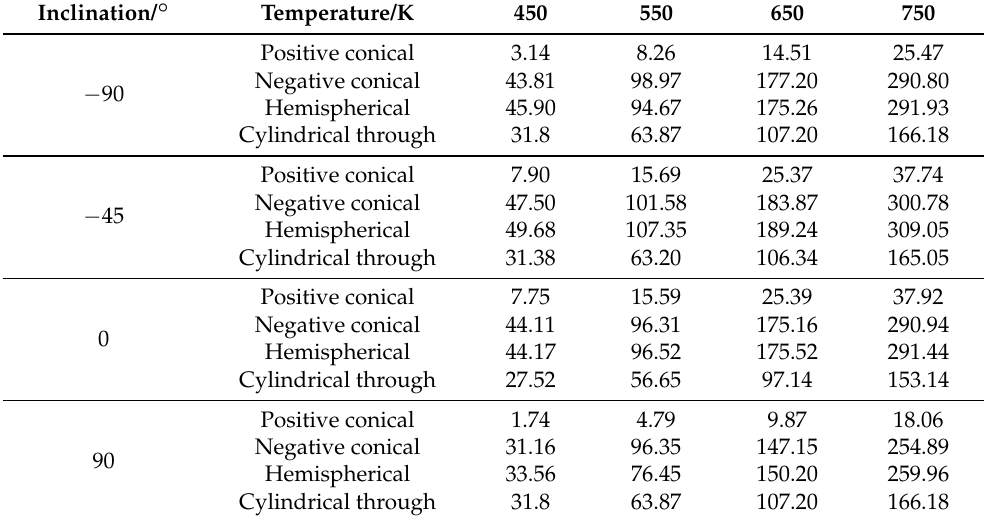
Table 5. Heat losses in